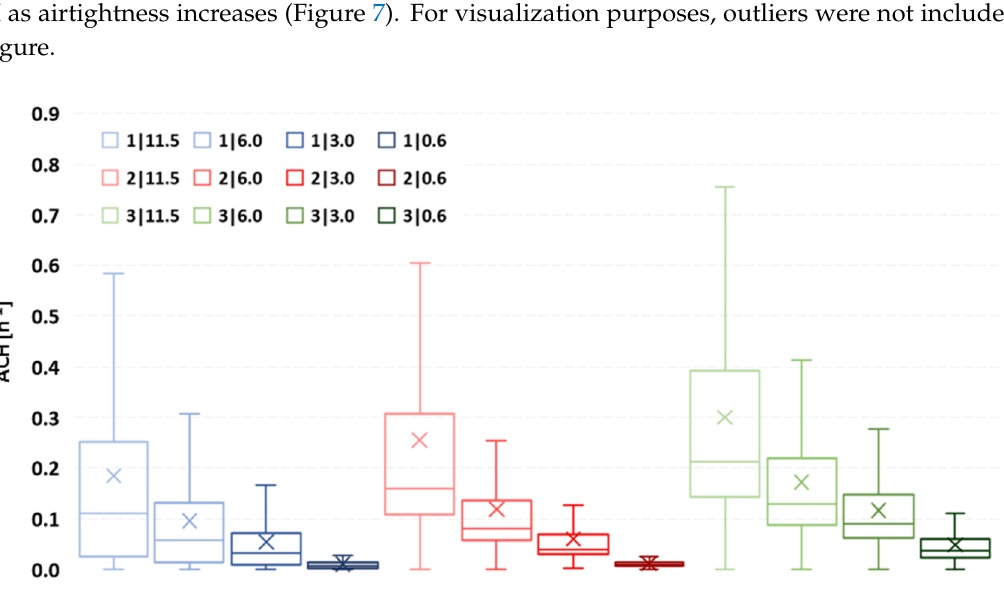
Figure 7. ACH distribution in the different configurations of air leakage paths for the four airtightness levels considered (Scenario|ACH 50 (h − 1 )); scenarios—1 (blue), 2 (red), 3 (green).